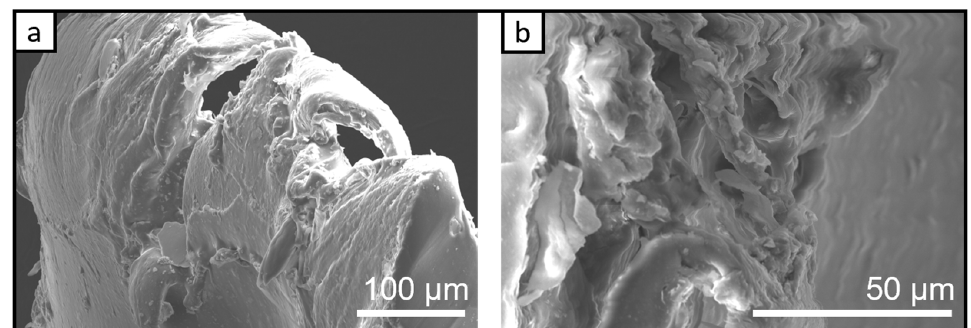
8 of 15 Figure 5. Representative SEM micrographs of bio ‐ PA1010 filled with 4% C500 graphene nano ‐